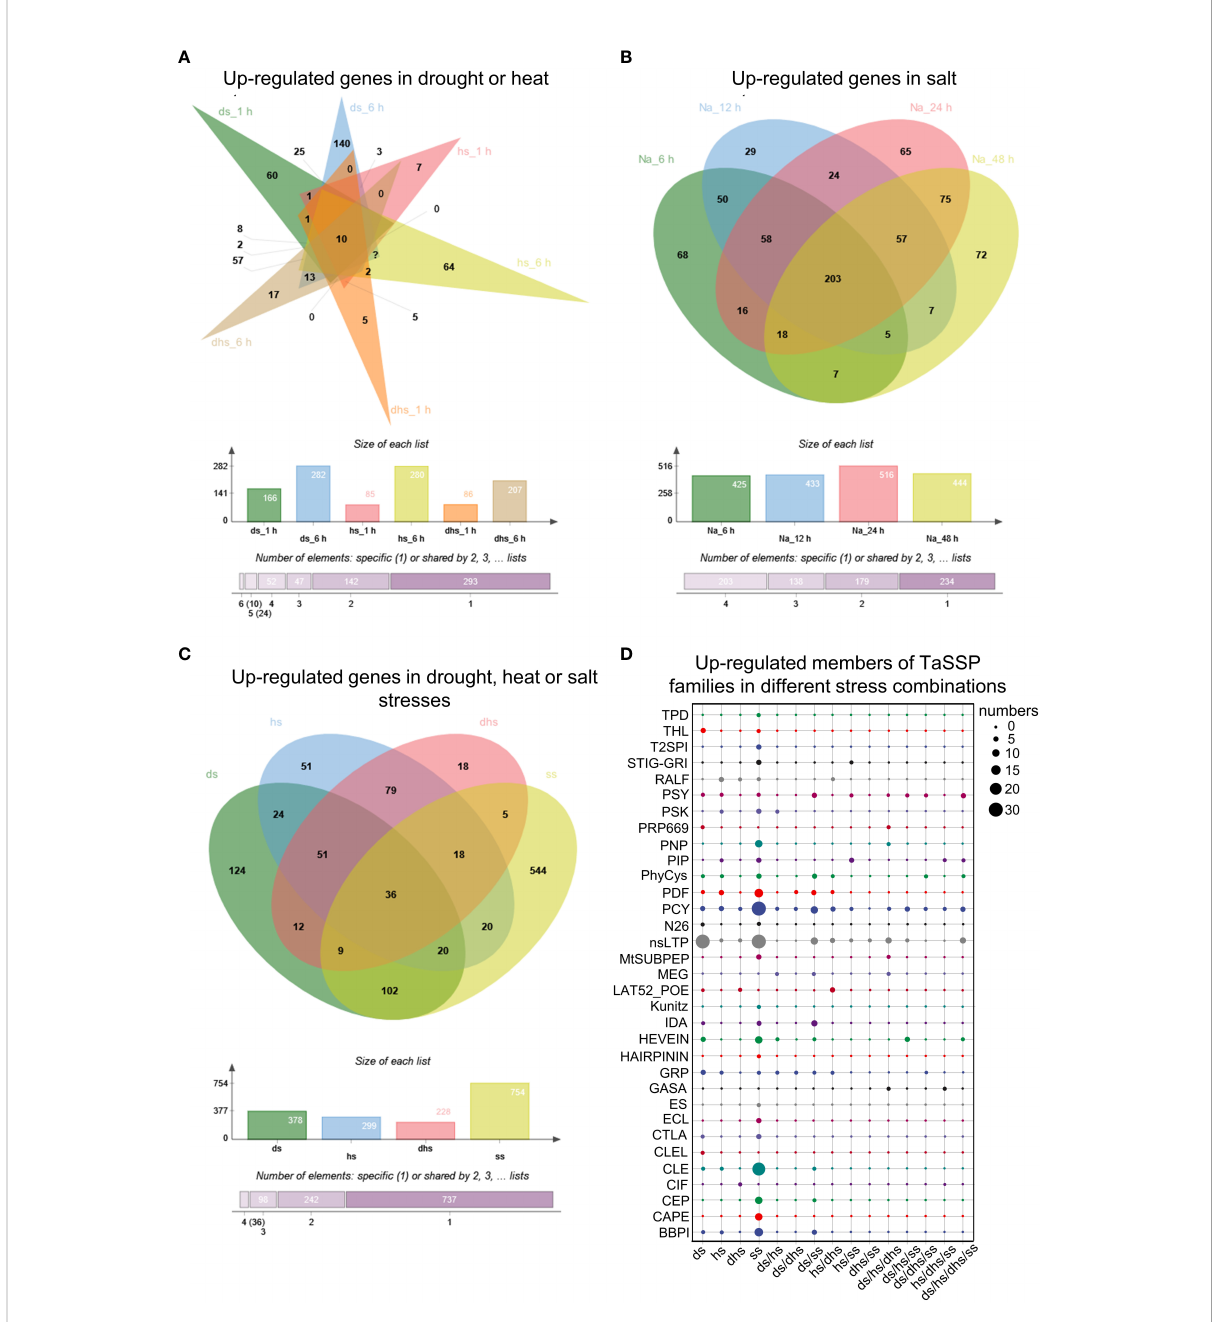
FIGURE 6 Expression analysis of TaSSPs under heat, drought and salt stress. (A) Upregulated TaSSPs in drought stress 1 h (ds_1 h), ds_6 h, heat stress1 h (hs_1 h), hs_6 h, drought and heat stress 1 h (dhs_1 h) and dhs_6 (h) (B) Upregulated TaSSPs in salt stress (ss) 6 h, 12 h, 24 h and 48 (h) Na indicates NaCl. (C) Upregulated TaSSPs in ds, hs or ss. (D) Upregulated members of TaSSP families in different stress combinations. The size of dots indicates the number of genes. The expression data was downloaded from WheatOmics 1.0